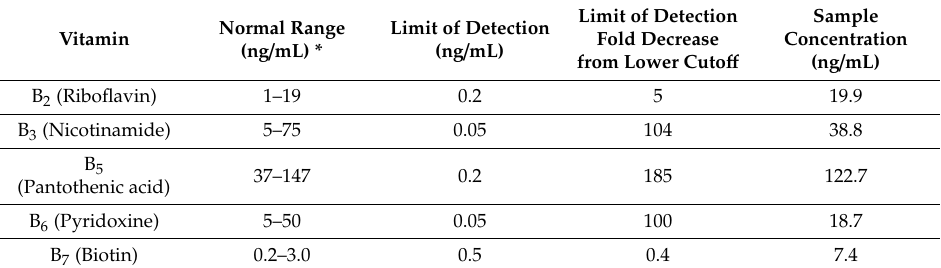
Table 4. Assessment of limit of detection and the concentration of pooled plasma sample.